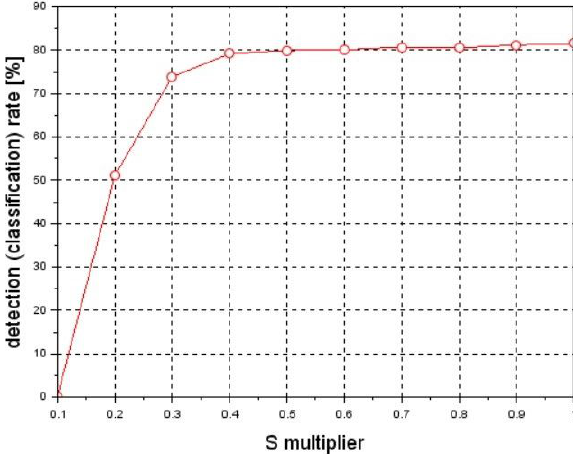
Figure 10: The detection rate versus changes in brightness of im- ages (represented by a S